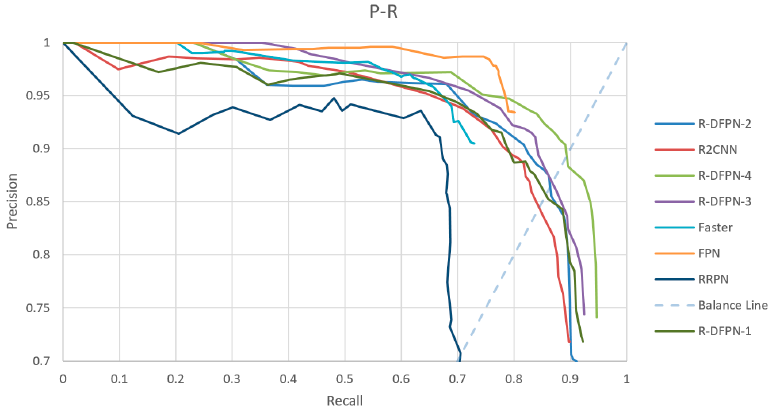
Figure 9. The P-R curves of different methods.